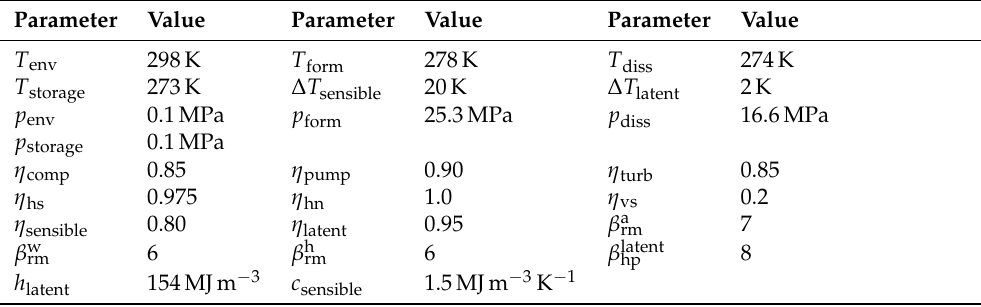
Table 1. Plant parameters of reference